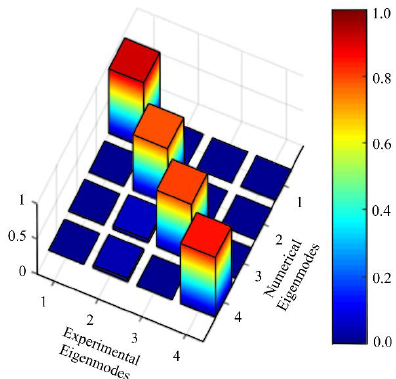
Figure 8. Modal Assurance Criterion (MAC) matrix comparing the results from the experimental